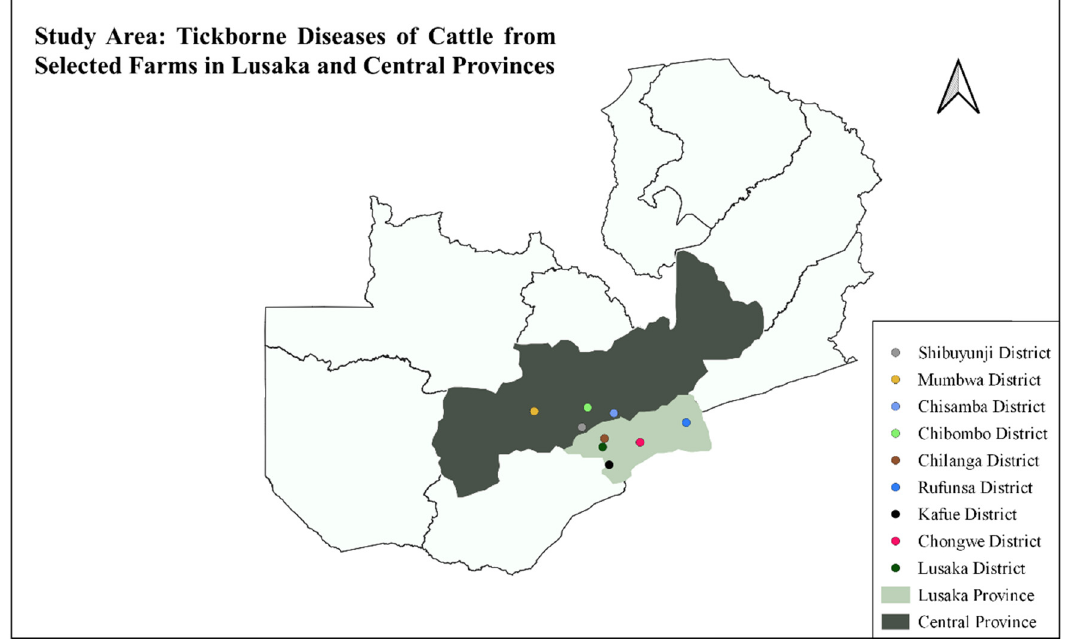
Figure 1: Study area showing districts and location of samples used in the analysis. ( Map generated using QGIS Desktop 3.24.1. )